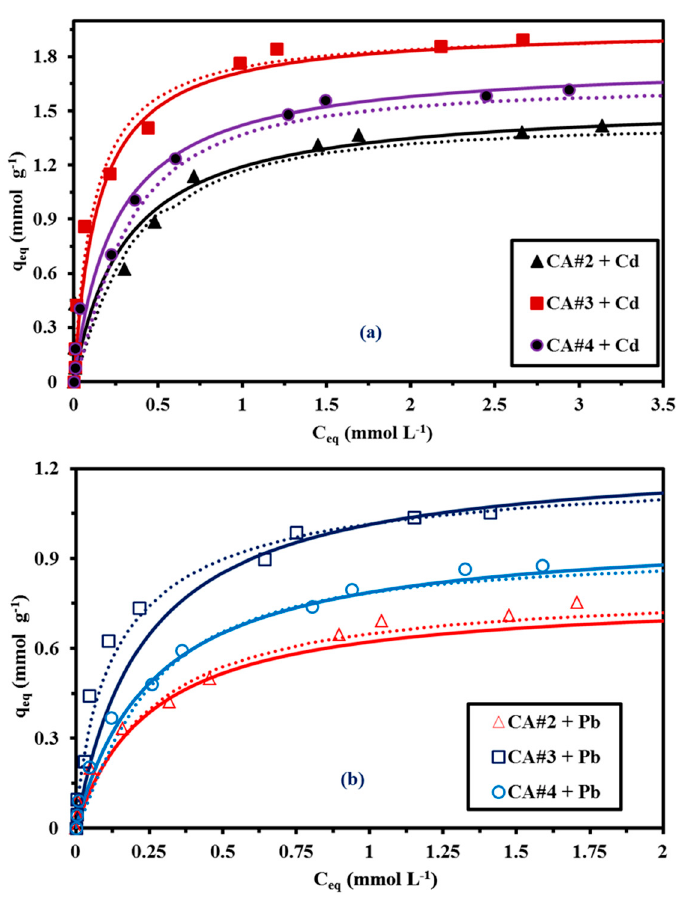
Figure 5. Sorption isotherms using CA sorbents ( a ) CA#2 + Cd, CA#3 + Cd, and CA#4 + Cd; and ( b )